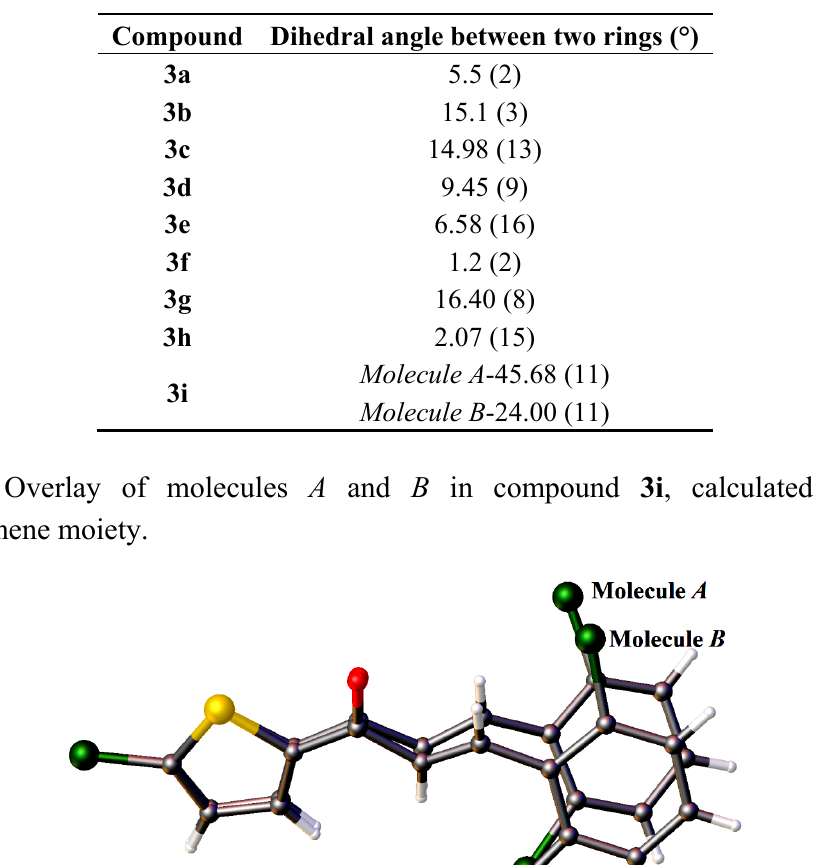
Table 2. The dihedral angles formed between the chlorothiophene and benzene rings.